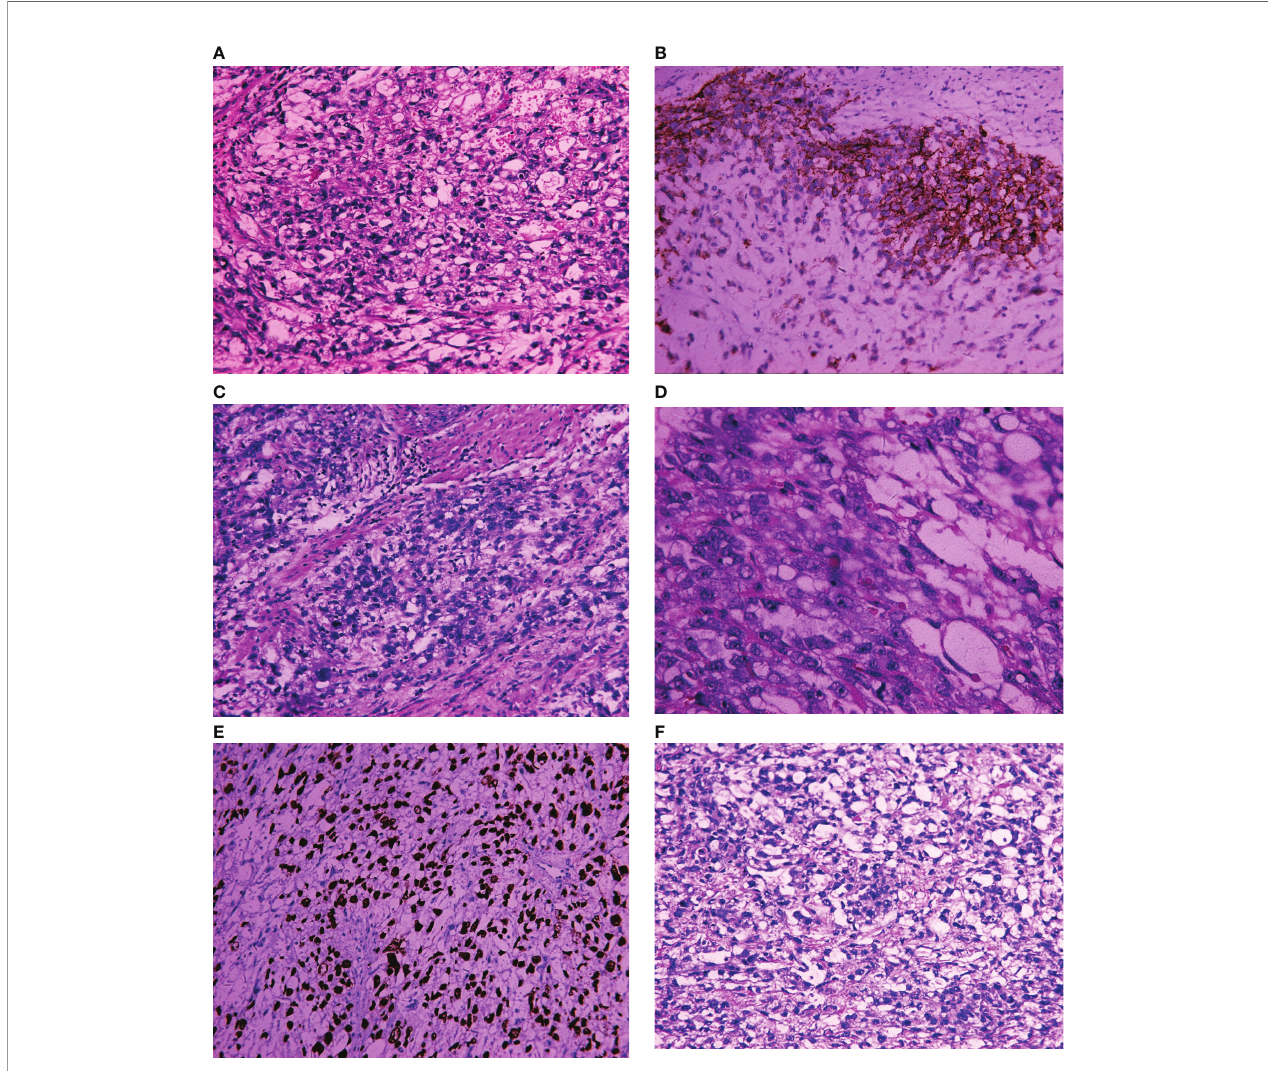
FIGURE 2 | Light microscopic appearance and immunohistochemical staining of endometrial YST. (A) Yolk sac structure (H and E, 10 × 40); (B) CD117+; (C) Germ cell tumor (GCT) cytology (H and E, 10 × 40); (D) Hyaloid drop (H and E, 10 × 40); (E) SALL4+; (F) Schiller – Duval body positive (H and E, 10 ×